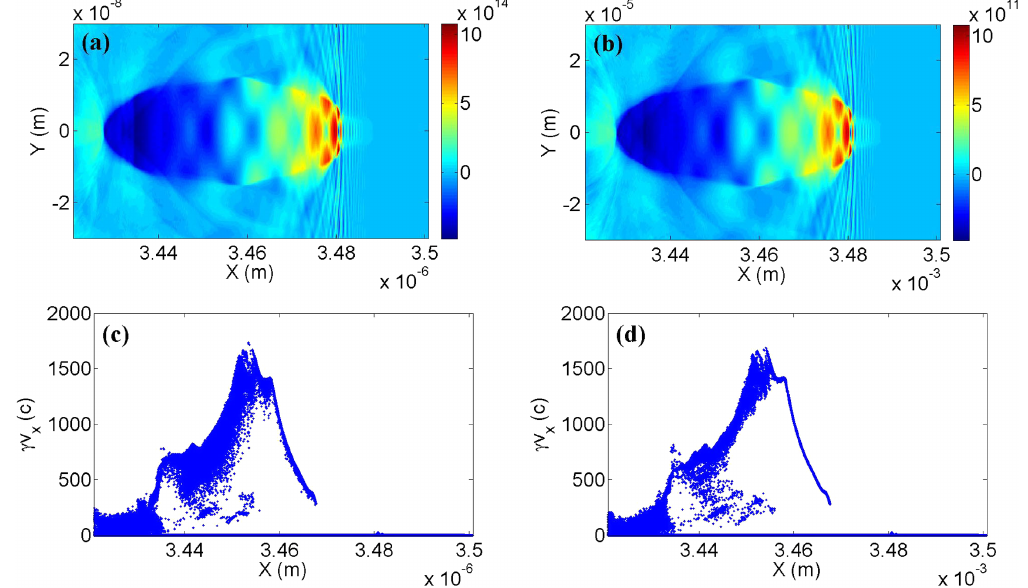
FIG. 4. Comparison and a certain scalability between the x-ray regime and the optical one. Distributions of (a) and (b) the longitudinal wakefield E x ð V = m Þ and (c) and (d) electron longitudinal momentum γ v x induced by (a) and (c) the x-ray laser pulse and (b) and (d) 1 eV optical laser pulse in a tube when a 0 ¼ 10 .